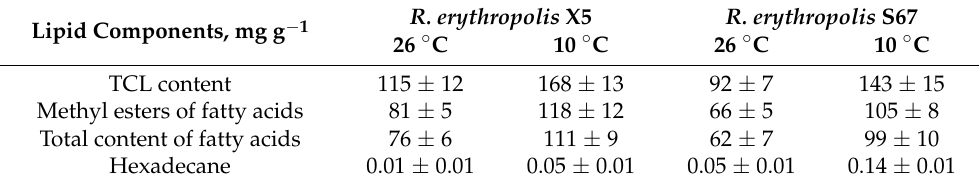
Methyl esters of fatty acids